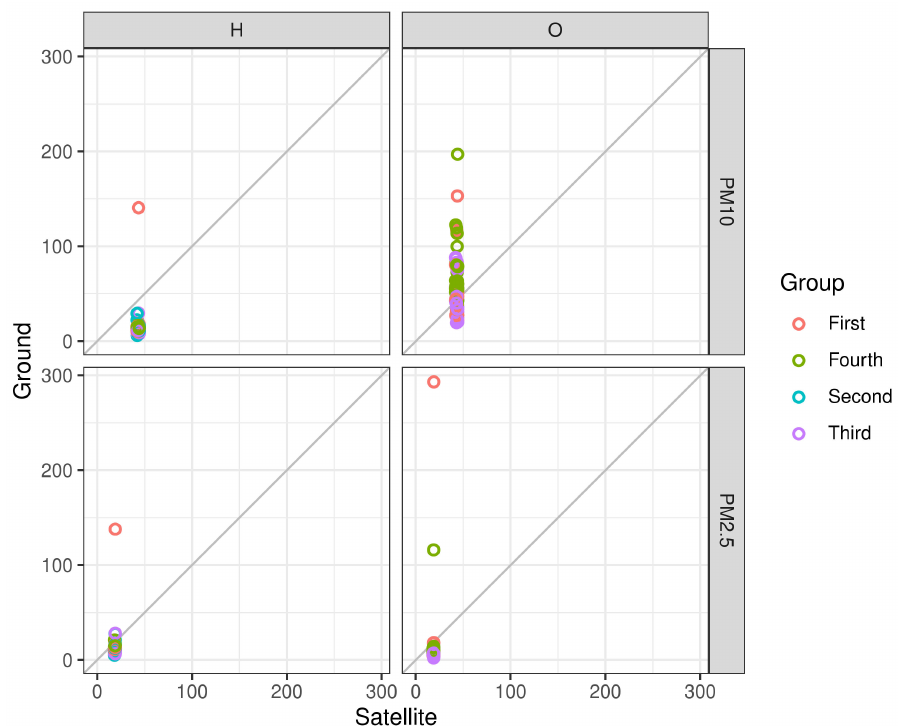
Figure 9. Mobile measurements comparison to satellite data, categorized by number (date of measurement).